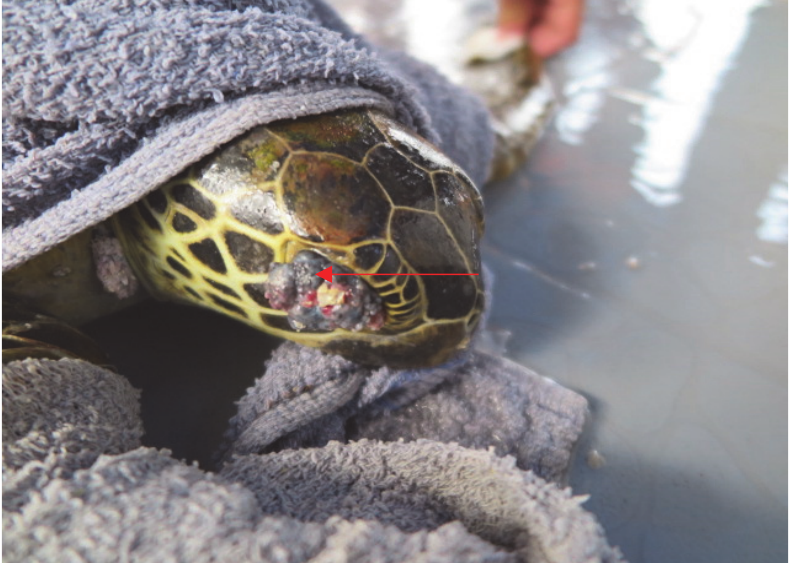
Figure 2. A juvenile green sea turtle with FP tumors (arrow) on its eyes, a condition known as corneal fibropapilloma, causing the affected sea turtle to be visually impaired. Table 2. Detection of ChHV5 in tissues with and without FP tumors in the green, hawksbill, and olive ridley